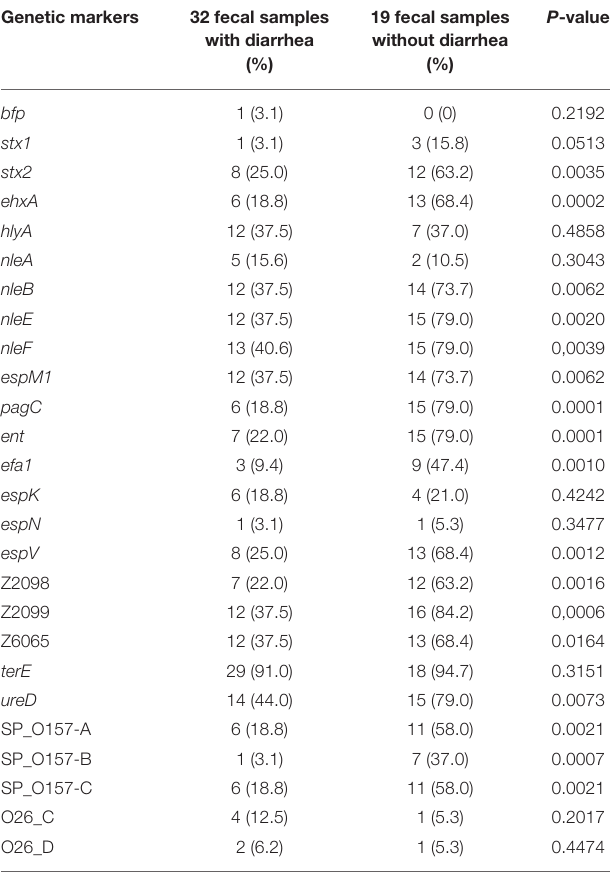
TABLE 3 | Virulence profile determination of eae + Escherichia coli from fecal samples of children with and without diarrhea*. Genetic